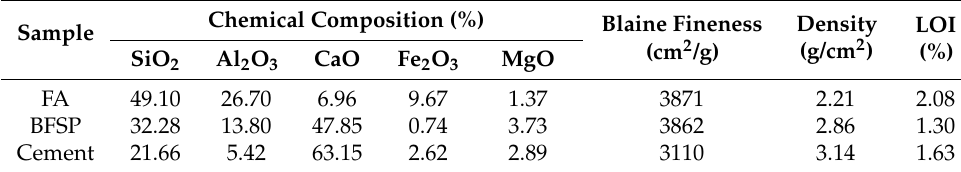
Table 1. Properties and compositions of the pozzolanic materials.